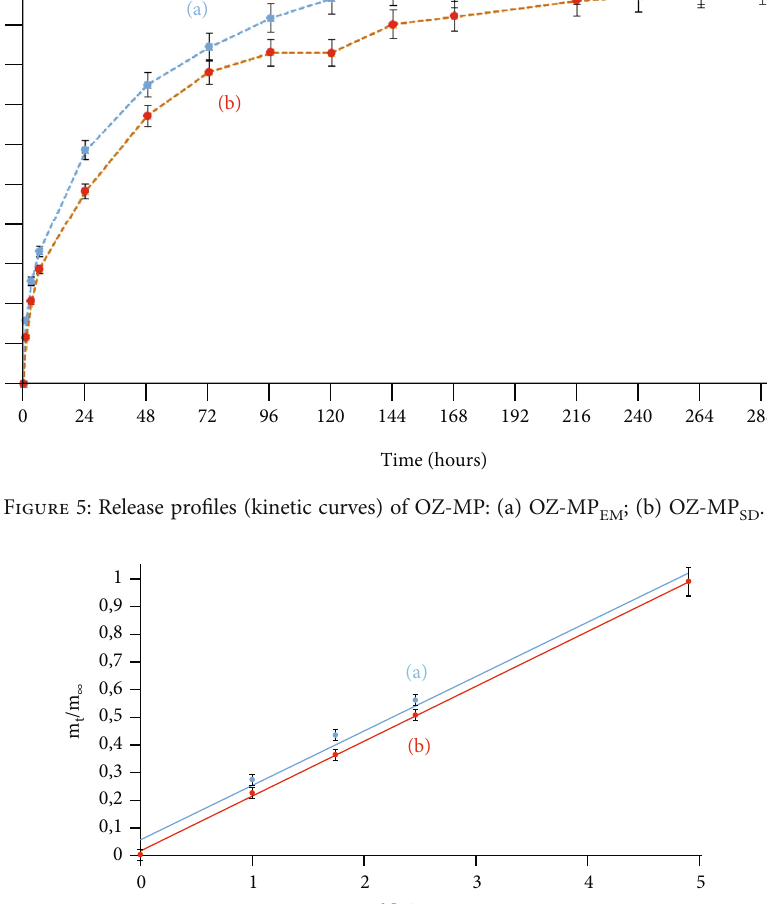
, R 2 = 0 : 988 ; (b) OZ-MP , R 2 = 0 : 998 . EM SD